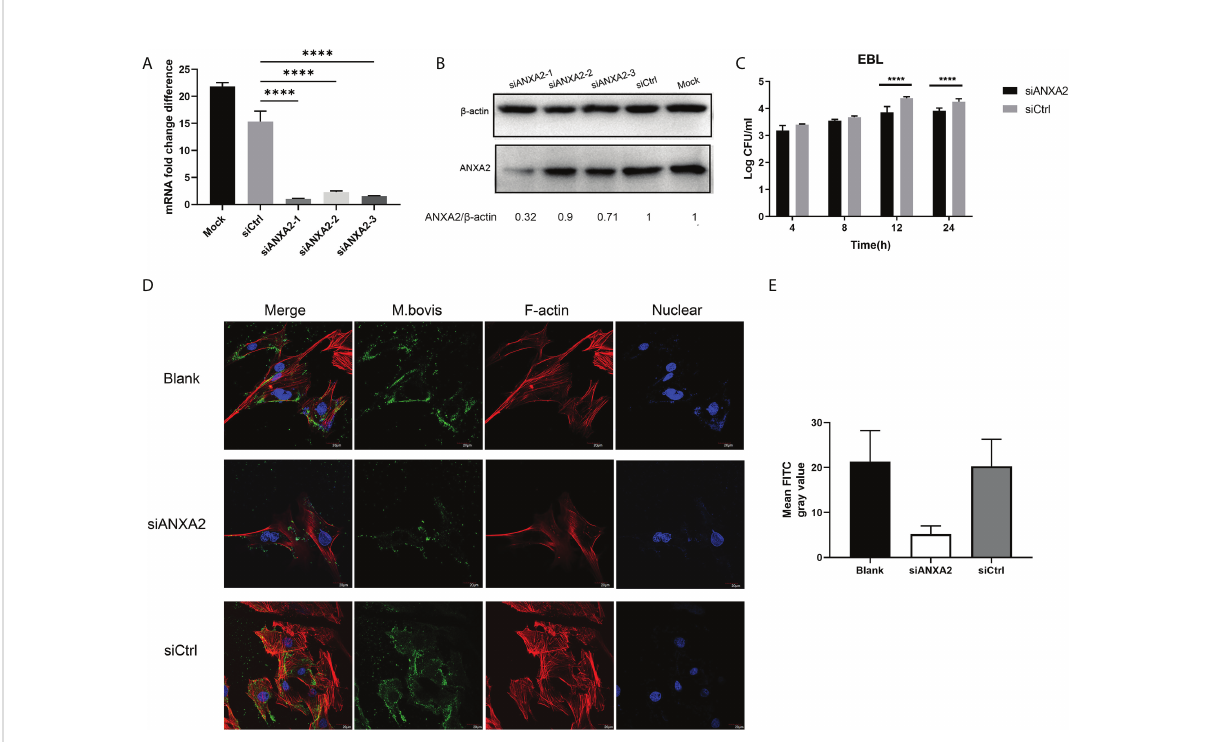
FIGURE 3 Effects of ANXA2 knockdown with siANXA2 on M. bovis invasion and actin polymerization in EBL cells. A , B . In siRNAs transfected EBL cells, qPCR (A) and western blot analysis (B) were used to con fi rm the inhibition of ANXA2 expression by three siANXA2 (siANXA2-1, siANXA2-2, and siANXA2-3) at the mRNA and protein levels. (C) Gentamicin invasion assay after ANXA2 knockdown with siANAX2-1 revealed that the amount of intracellular M. bovis signi fi cantly reduced after 12 and 24 h of infection. The shown data are the mean values of three independent experiments in triplicate. Standard deviations of measurements are indicated by error bars. **** p < 0.0001. (D) Confocal laser scanning micrographs of EBL cells without or with ANXA2 knockdown by siANAX2-1 and infected with M. bovis at a magni fi cation of 1000 for 12 h. Actin was stained red with rhodamine phalloidin, and the nuclei were counterstained with DAPI (blue), whereas M. bovis was stained with anti- M. bovis mAb and FITC- labeled secondary antibodies (green). The more actin in the bundle and more M. bovis associated with EBL cells was noticed in blank and siCtrl than the cells with ANXA2 knockdown by siANXA2-1. (E) Quantitative analysis of FITC channel intensity representing M. bovis staining. Ten cells from three different sights were randomly selected for analysis. Values are presented as mean ±